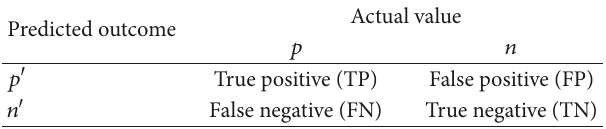
Table 1: Contingency matrix for two-class prediction problem. Predicted outcome